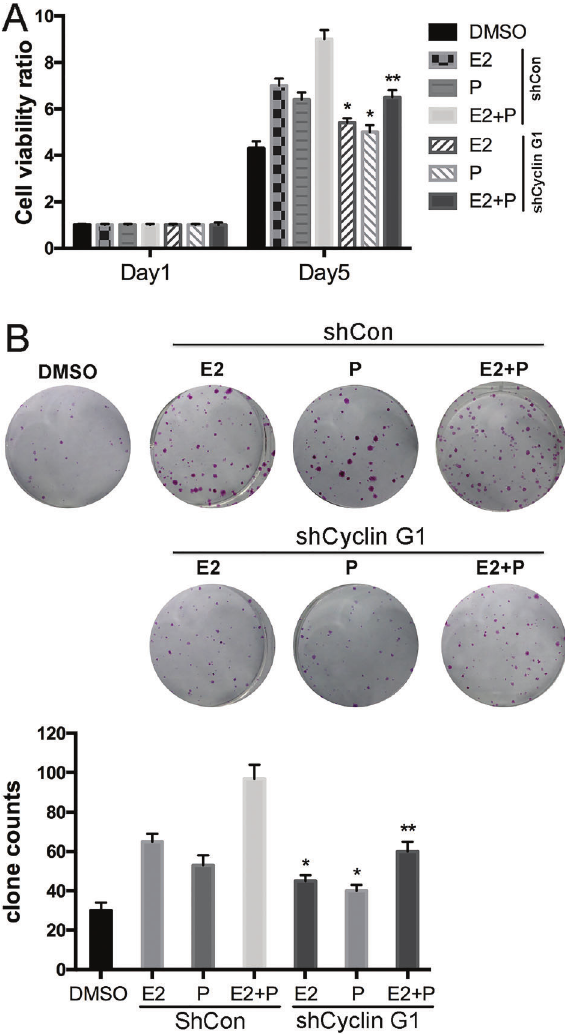
Figure 6. A , Knockdown of cyclin G1 (shCyclin G1) limits estradiol (E2)- and progesterone (P)-mediated MCF-7 cell proliferation. B , Knockdown of cyclin G1 decreased the colony number by up to 28% in single E2 treatment groups, 25.5% in single P treatment groups, and 40% in E2 + P treatment groups (lower panel). Data are reported as means ± SD. *P o 0.05 and **P o 0.01 vs shCon groups (Student ’ s t -test).